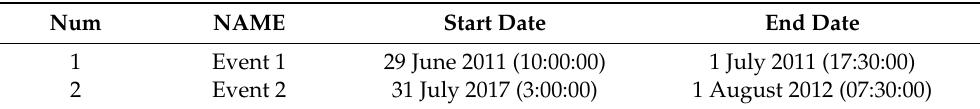
Table 2. Duration of Rainfall